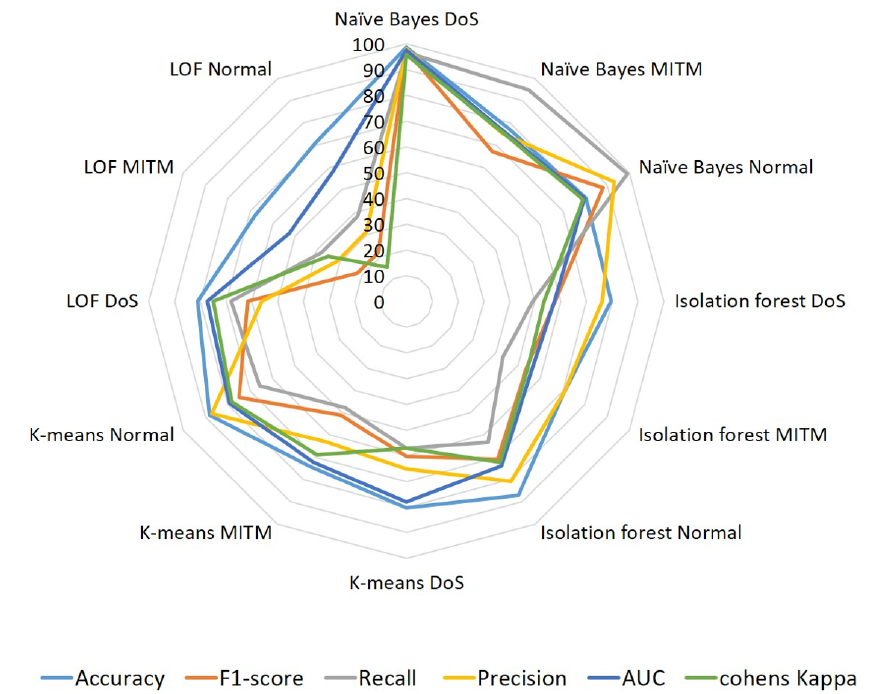
Figure 6. Performances of BLE–unsupervised ML algorithms. Multiple attacks were trained on the same models of BR/EDR; we observe that the models are not biased.